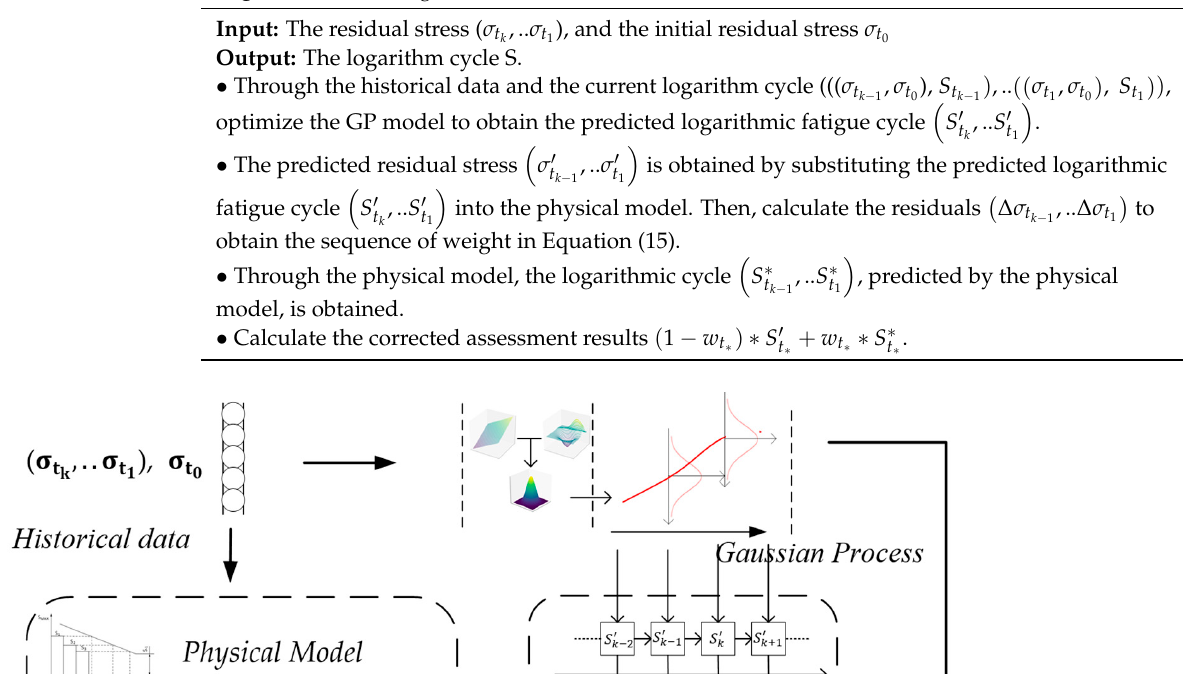
Algorithm 1: The Algorithm of GP-SS